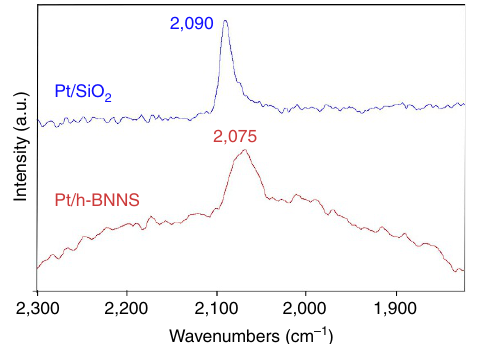
Figure 7 | In situ FTIR spectra of CO adsorbed on Pt/ h- BNNS and Pt/SiO 2 at room temperature. Temperature ¼ 25 (cid:2) C. Features from gas phase CO have been Respective BEs of CO and O 2 were calculated according to: BE CO/O2* ¼ E CO/O2* (cid:2) E Pt4 on h -BNNS (cid:2) E CO/O2(g). Data availability . The authors declare that the data supporting the findings of this study are available from the corresponding author on reasonable request.